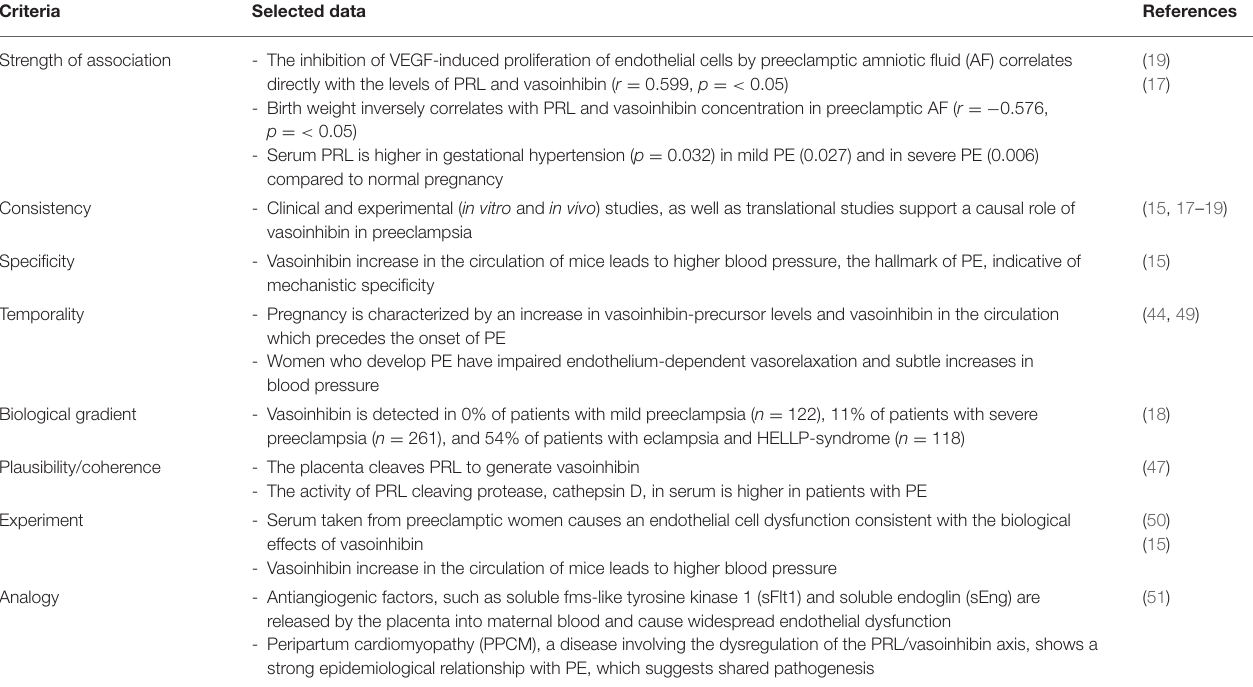
TABLE 3 | Causal inference between vasoinhibin dysregulation and preeclampsia: application of the 2015 Bradford Hill criteria